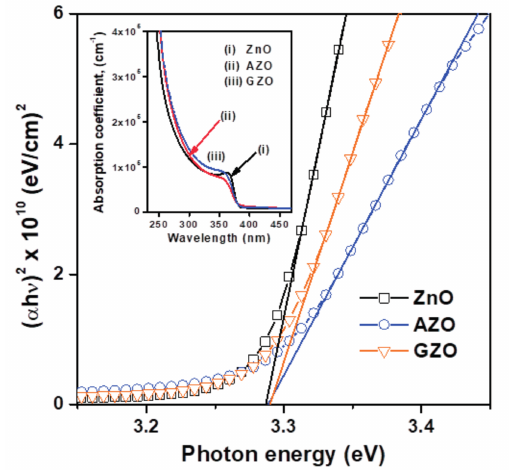
Figure 6. Plot of ( α h ν ) 2 versus photon energy ( h ν ) of ZnO, AZO, and GZO thin films. In the inset, the plot of absorption coefficient with wavelength close to absorption edge is